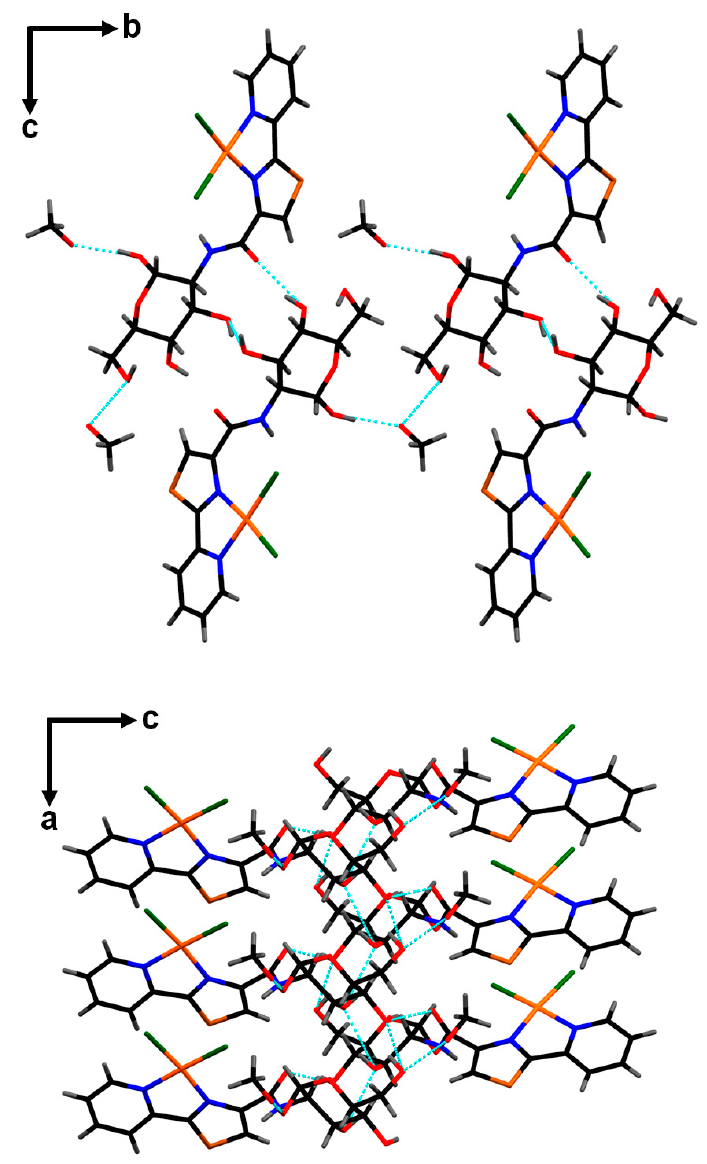
Figure 2. Crystal packing of 2 ·MeOH viewed along the a -axis ( top ) and b -axis ( bottom ). Hydrogen bonds are represented by the dotted blue lines.